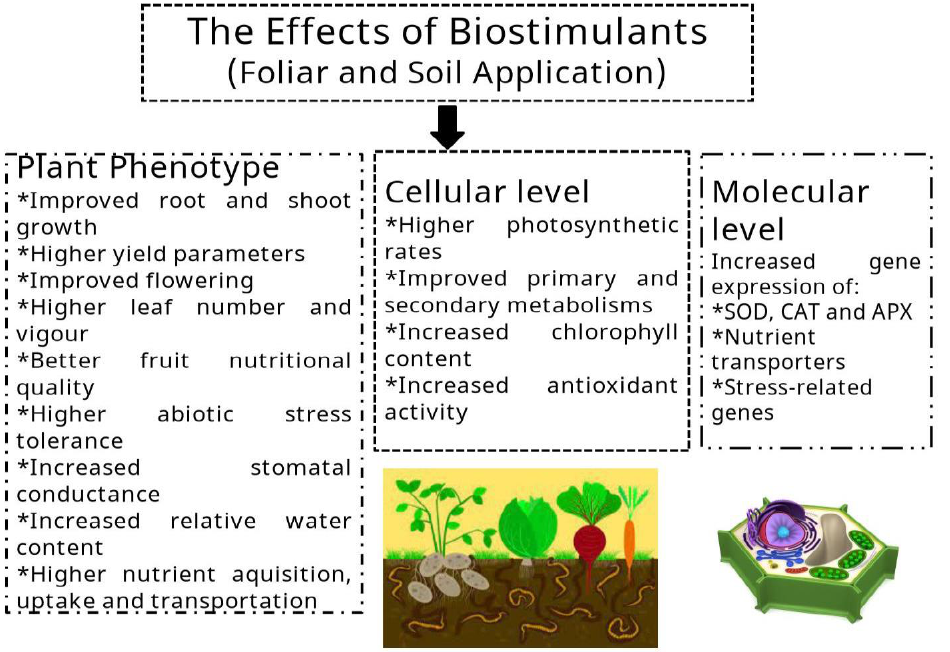
Figure 1. The principal mechanisms targeted by microorganisms based of different biostimulants.